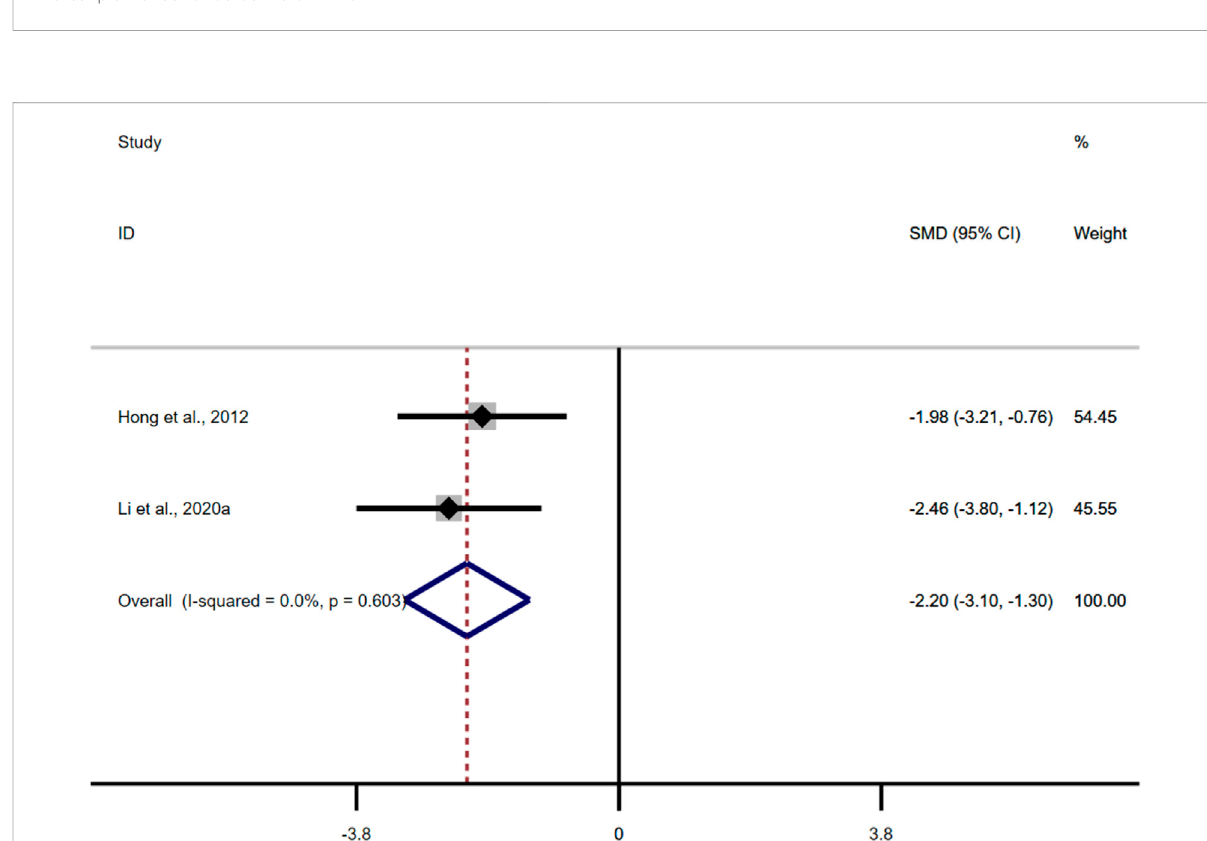
FIGURE 9 Forest plot: effect of berberine on